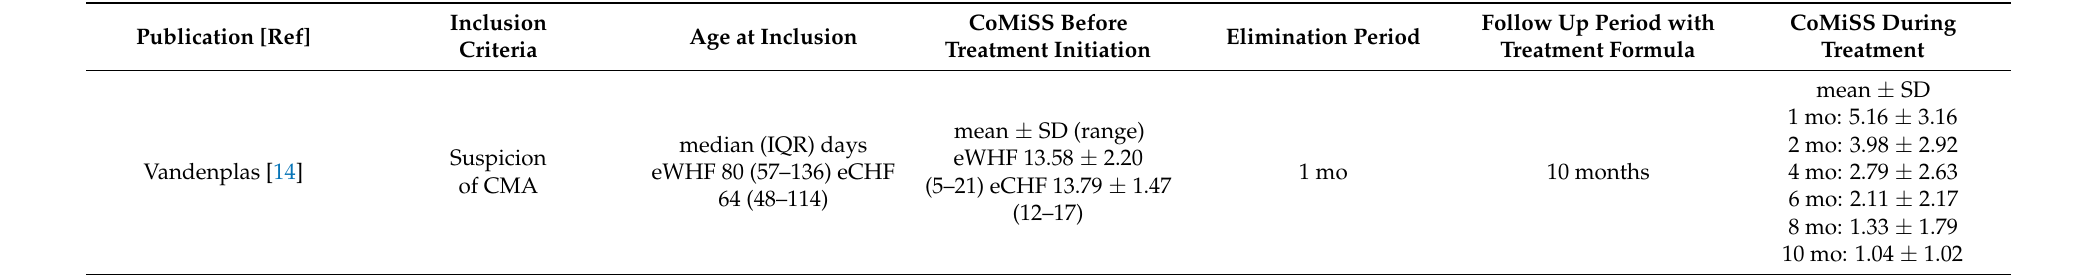
Table 7. CoMiSS as a validation tool of efficacy and safety in studies on new treatment